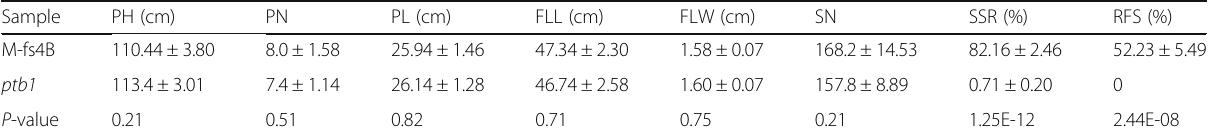
Table 2 Comparison of main agronomic traits between transgenic line M-fs4B and the ptb1 mutant Sample